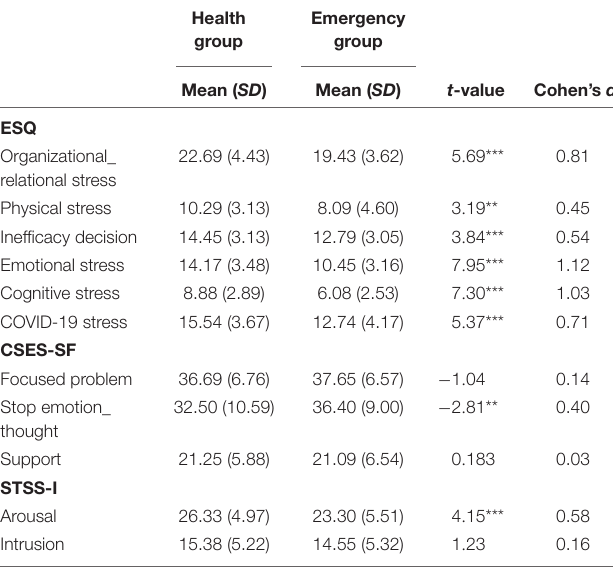
TABLE 2 | Differences in STSS-I, ESQ, and CSES-SF between Health and Emergency Groups ( n =